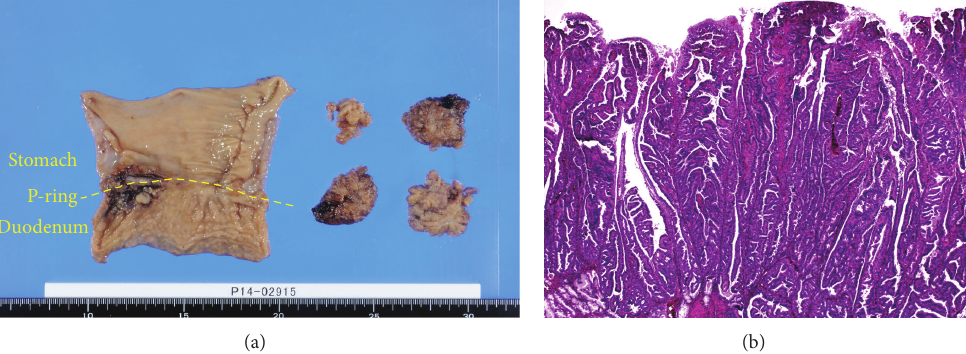
Figure 3: (a) The tumor resected via distal gastrectomy after submucosal resection via an incision in the gastric anterior wall. (b) The histopathologic diagnosis-papillary adenocarcinoma, and the invasion depth is the mucosal layer without vascular invasion.